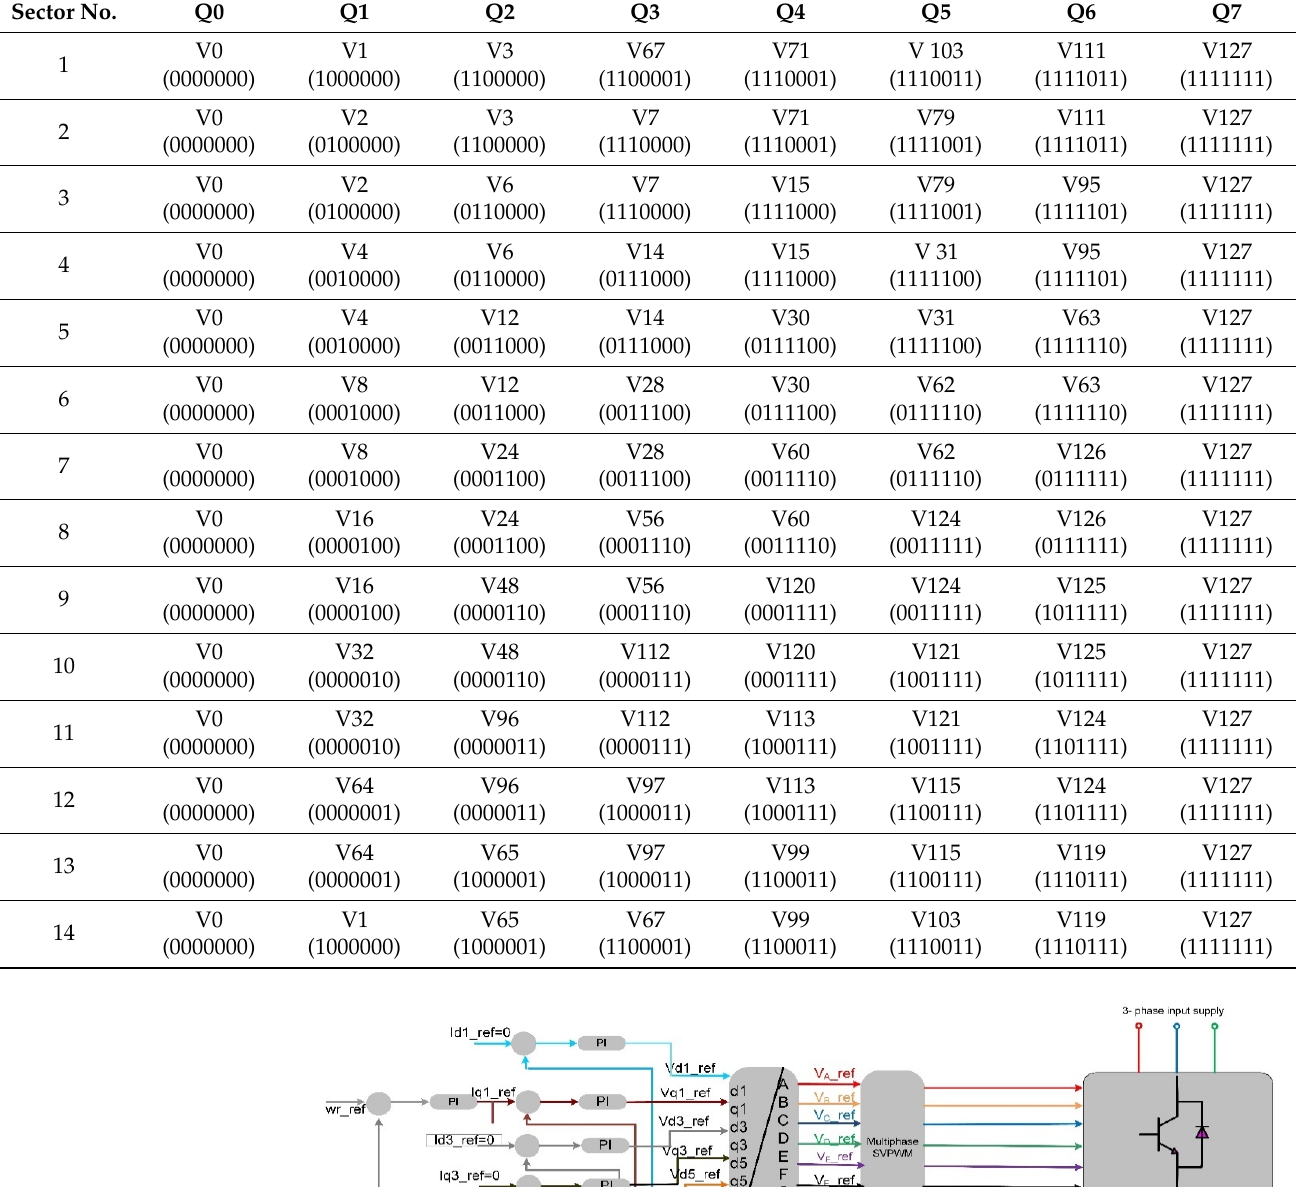
Table 2. Switching sequences in different sectors using NSV-SVPWM.